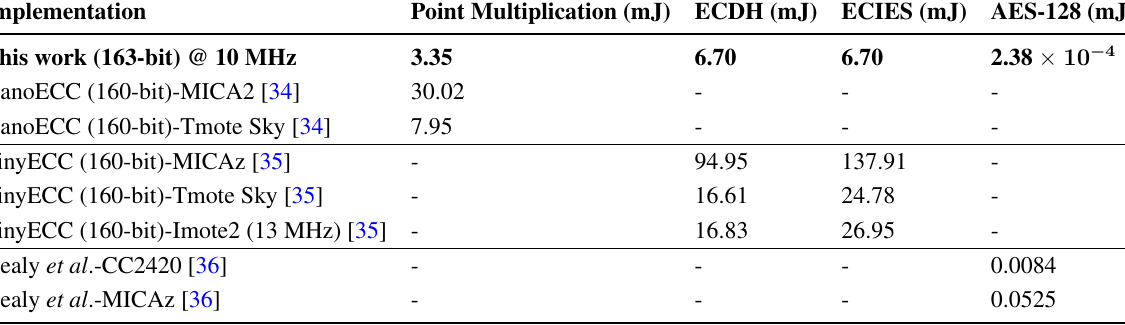
Table 10. Comparison on energy consumption (mJ) with other ECC and AES-128 implementations in commercial sensor nodes